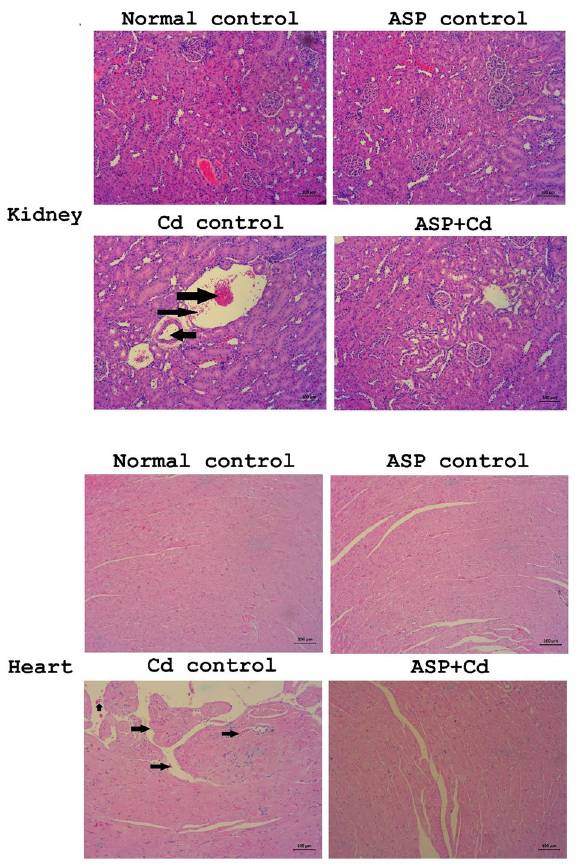
Figure 5. Histopathological changes in the kidney and heart tissues of cadmium administered rats . Black arrows: renal tubule and aggregates of inflammatory cells. X 400. Bar = 100